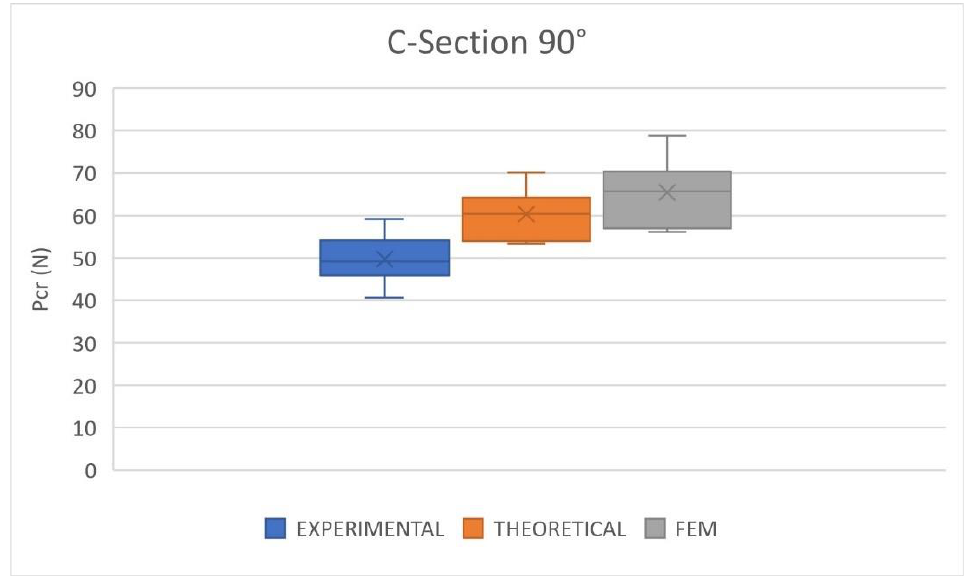
Figure 11. Critical buckling load. Comparison between experimental, theoretical and FEM results. C90 cross-section.